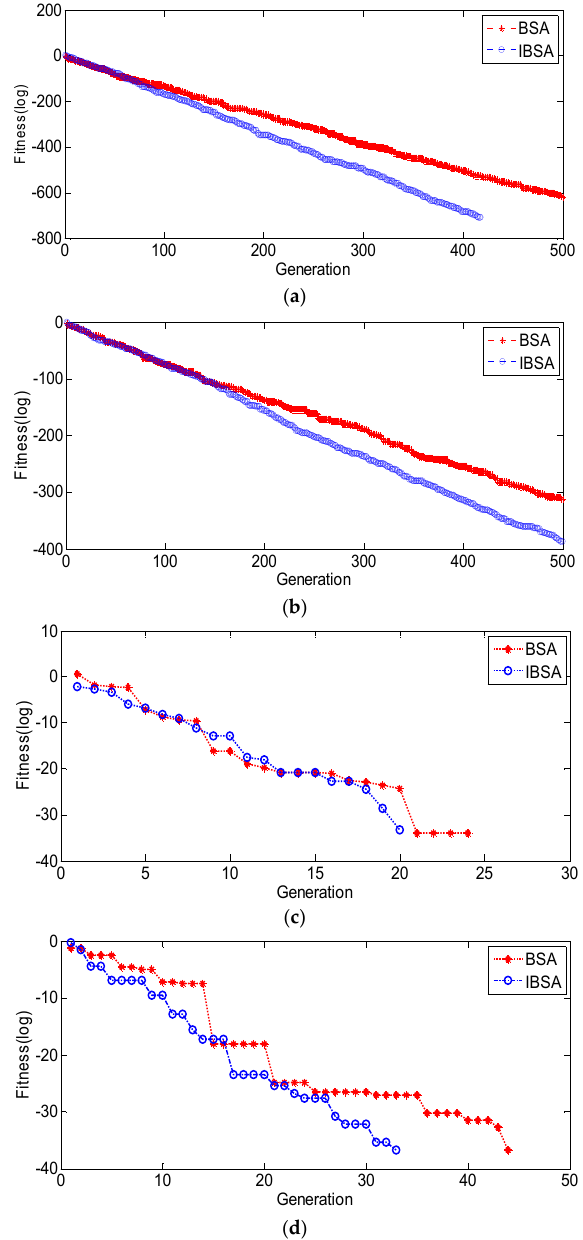
Figure 1. The optimization curves of BSA and IBSA optimizers. ( a ) Optimization curves for F1; ( b ) Optimization curves for F2; ( c ) Optimization curves for F3; ( d ) Optimization curves for F4.